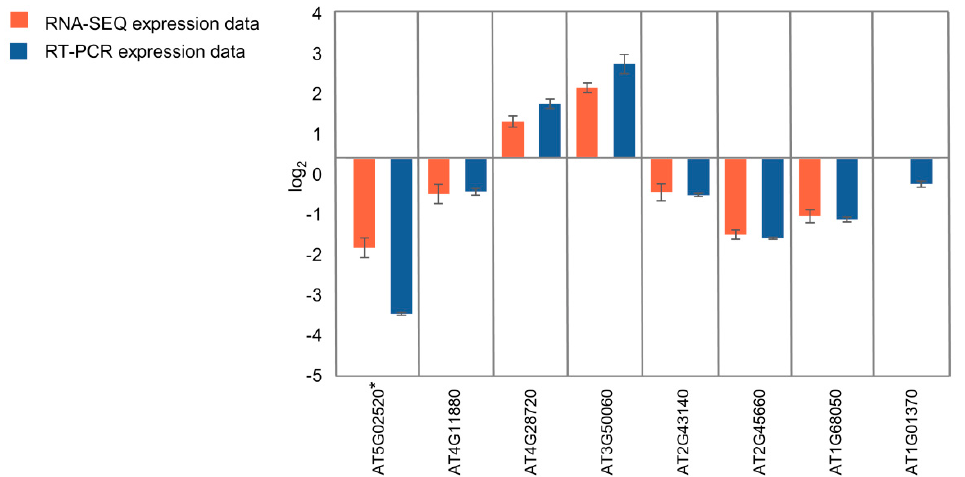
Figure 7. qRT–PCR validation of RNA-seq results. Eight genes were selected from the genes di ff erentially expressed in seedlings according to the RNA-seq data analysis. Detailed annotation of the selected genes is presented in Table S2 (Supplementary Materials). *At5g02520 corresponds to KNL2 . Error bars indicate the standard error of three biological replicates in qRT-PCR.